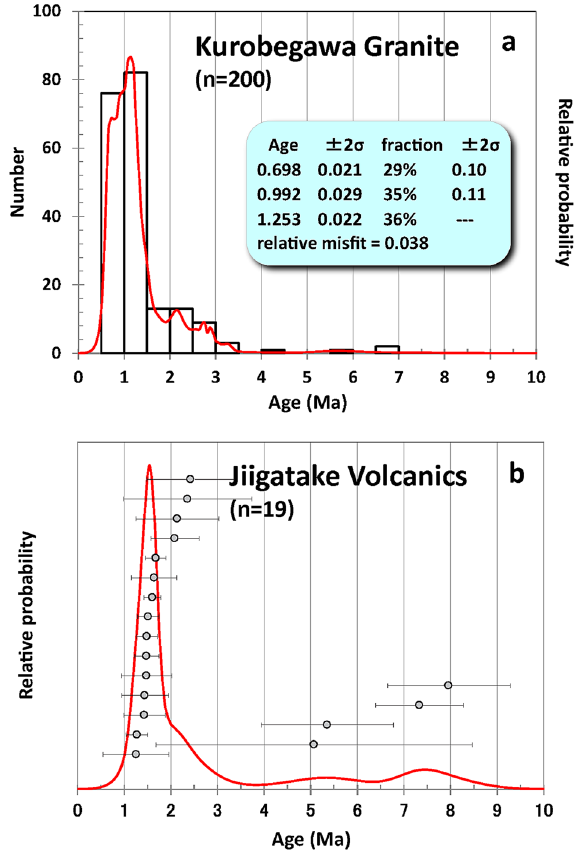
Figure 7. 238 U– 206 Pb age distributions (histogram, probability density plot) for zircon younger than 10 Ma for ( a ) the Kurobegawa Granite (including ~ 2 Ma portion) and ( b ) the Jiigatake Volcanics. The inset in ( a ) shows the result of age peak deconvolution using Isoplot 35 . The deconvolution was performed for ages < 1.55 Ma to analyze grouping of zircon ages after the ~ 1.55 Ma Jiigatake eruption. In ( b ), individual grain ages with 2σ uncertainty are also plotted. n = number of grains